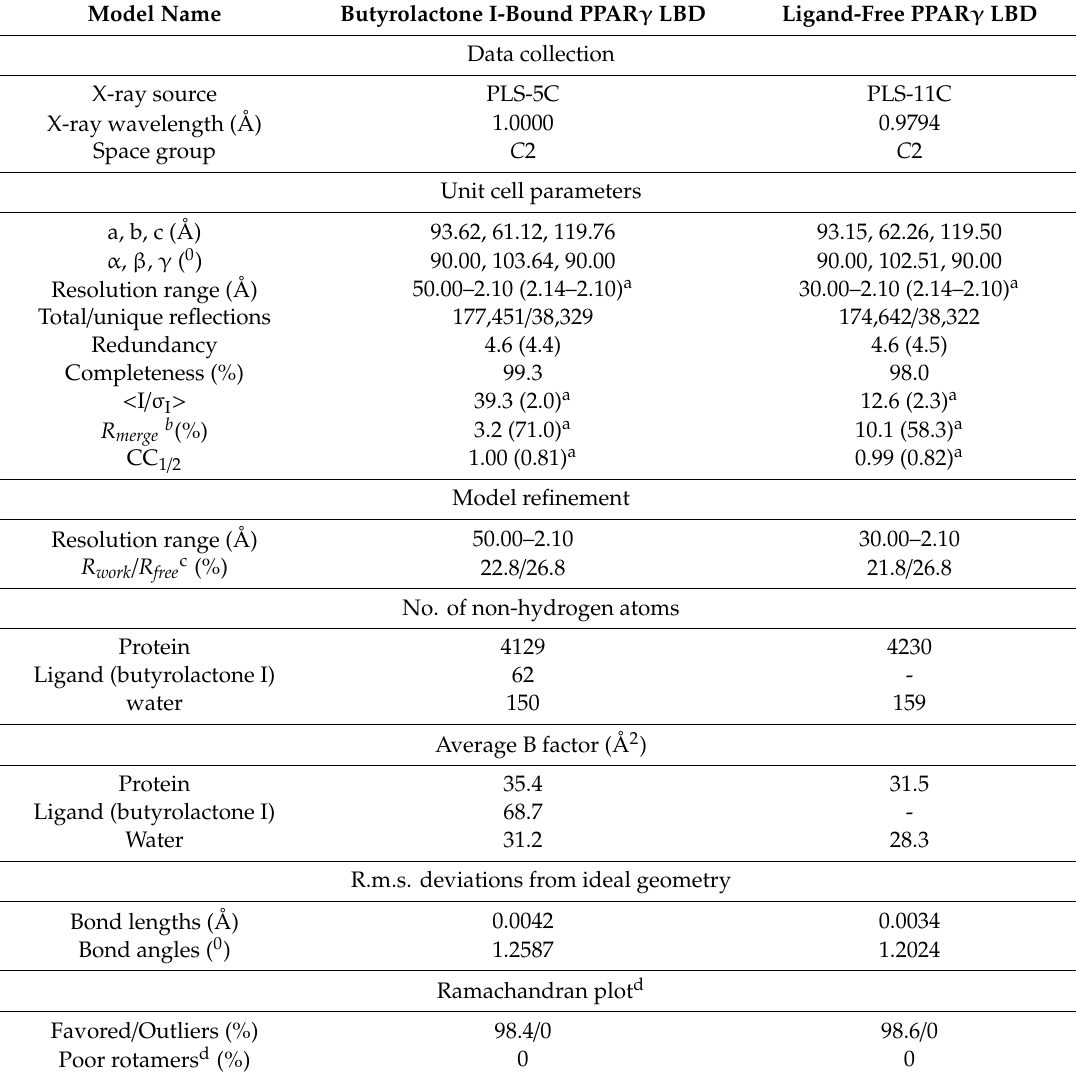
Σ | I(h) < I(h) >|/ Σ Σ h i i – h i I(h) i , where I(h) is